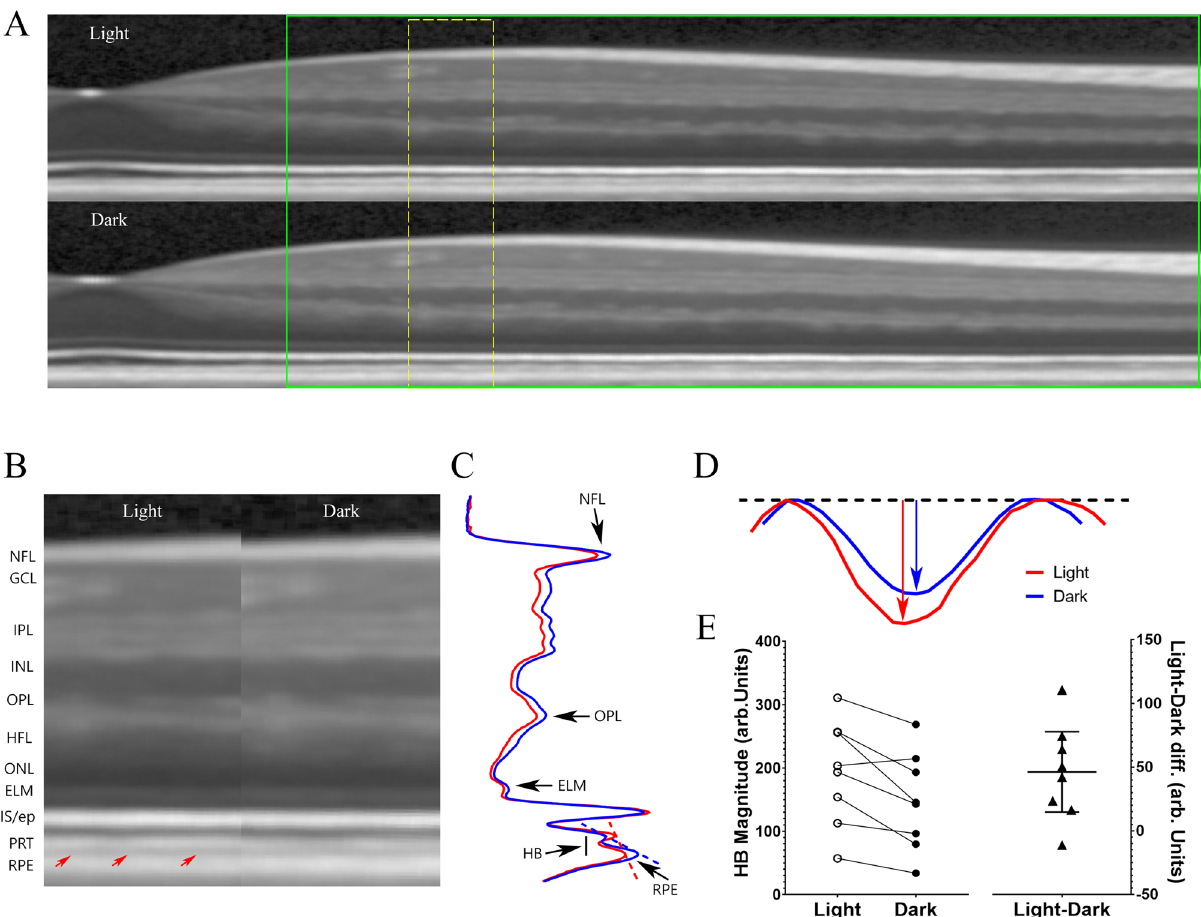
Figure 5. Effect of light and dark adaptation of HB magnitude on human subjects. (A) Representative OCT images from a human eye captured under light and dark conditions. Images were flatted along RPE band. Regions marked by green box outline images used for calculating HB magnitude. (B) Magnified OCT images from region outlined by yellow dash line in (A) showed side-by-side. The location of the HB is marked by red arrows for the light-adapted retina. (C) Intensity profiles calculated from images shown in (B) with HB region marked by a bar on left. The dashed lines represent the baseline constructed by connecting the maximal intensity for photoreceptor tip layer and RPE layer. (D) Magnified view of HB with the baselines rotated and aligned. HB magnitude is measured as the peak distance from the baseline line. (E) HB magnitude under light and dark conditions for 8 subjects (left panel) and Light–dark difference of HB magnitude (right panel). Error bar represents 95% credibility interval. Please note that different hardware and grayscale outputs were used for OCT images collected for human and mouse